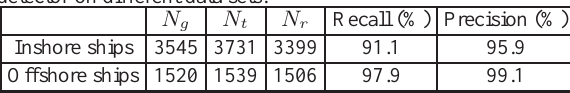
Table 1: Precision and recall of our proposed S-CNN-based ship detector on different data sets. N g N